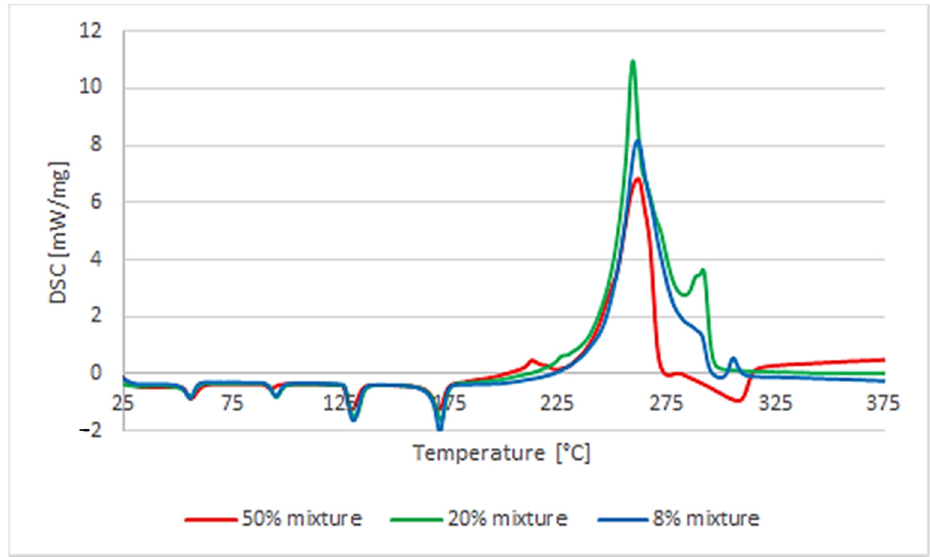
Figure 5. DSC analysis of AN and soft PVC (PVC-P) mixture composition influence on their thermal properties, heat rate 10 °C/min.